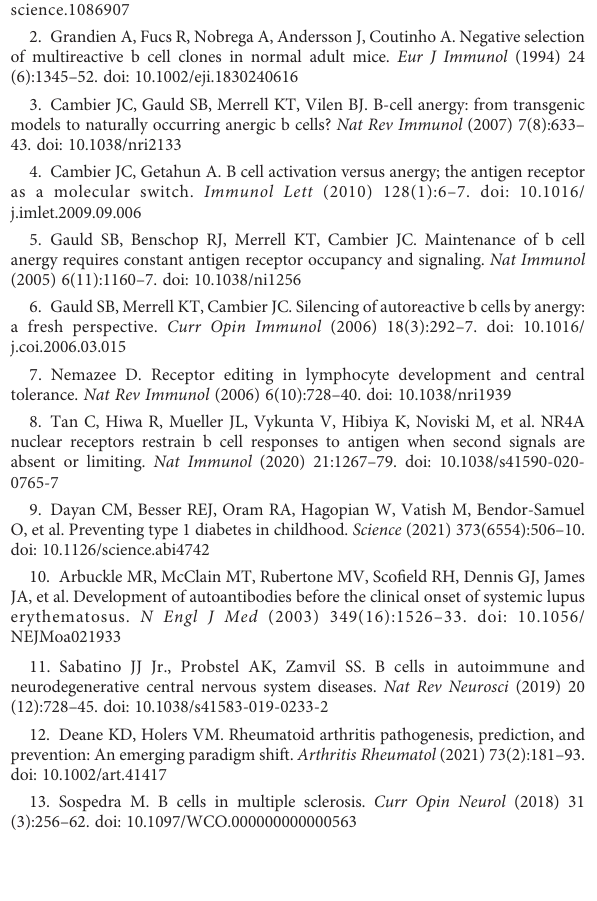
SUPPLEMENTARY TABLE 3 Genes involved in lupus, type 1 diabetes, peripheral and central B cell tolerance from mouse models – Murine locus – genetic locus, gene name or common protein name of the gene. Gene location – murine chromosome and cytoband of the gene in question. GL Murine – gene location on chromosome in centimorgans. Human orthologue –